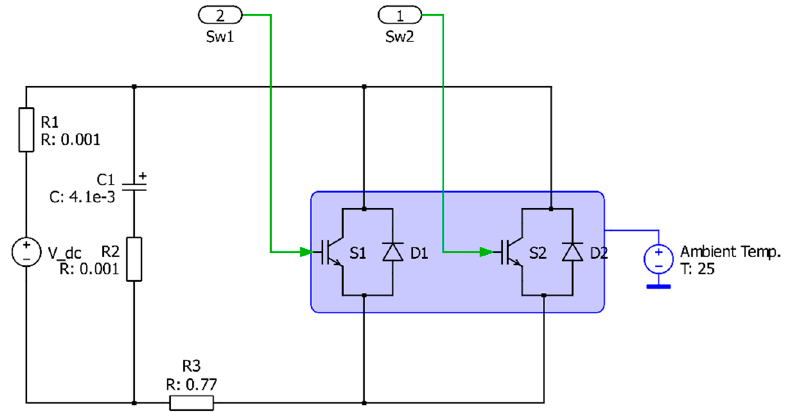
Figure 8. PLECS model for the IGBT heat flux measurements.